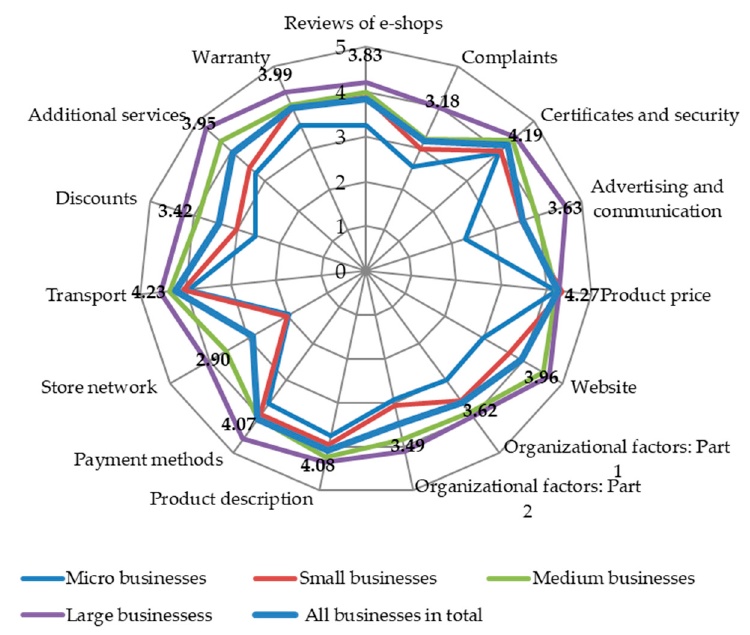
Figure 1. Quality of factors of online shopping behavior according to the business size. Source: own research.